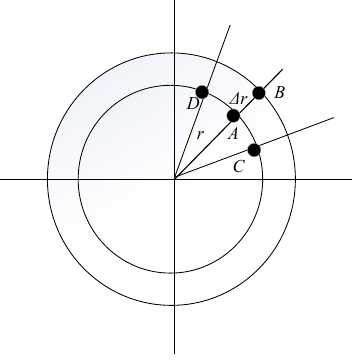
g and C . , θ r , θ r point on the circle of radius r . Point B